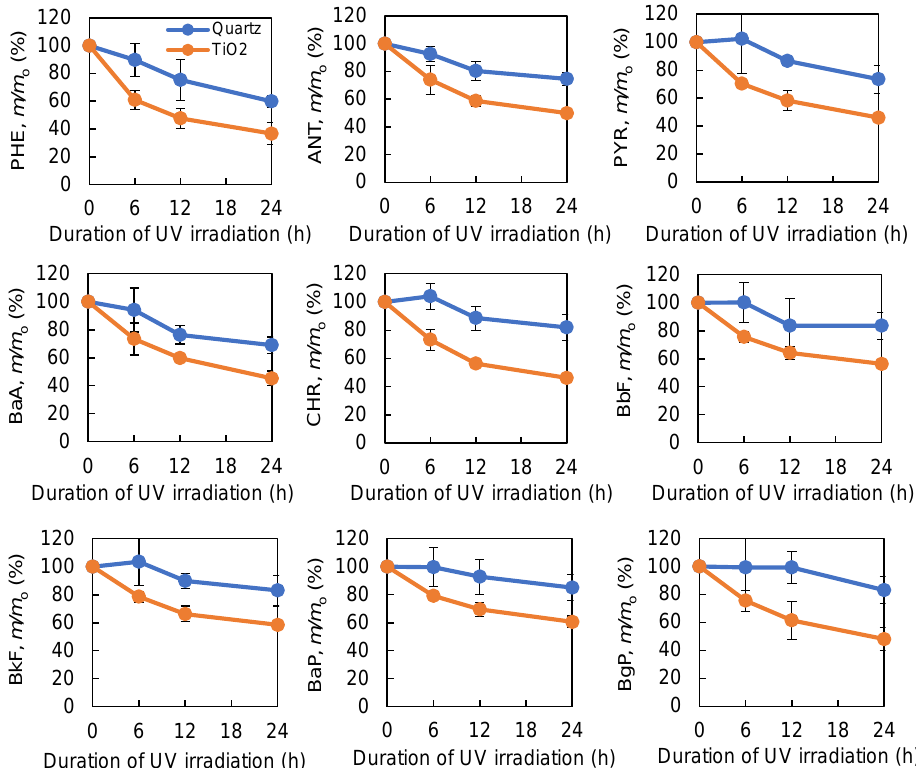
Figure 4. UV-induced degradation of PAHs in PM 2.5 collected on quartz filters and TiO 2 filters. Plots show the averages of three samples and error bars show the standard deviations.